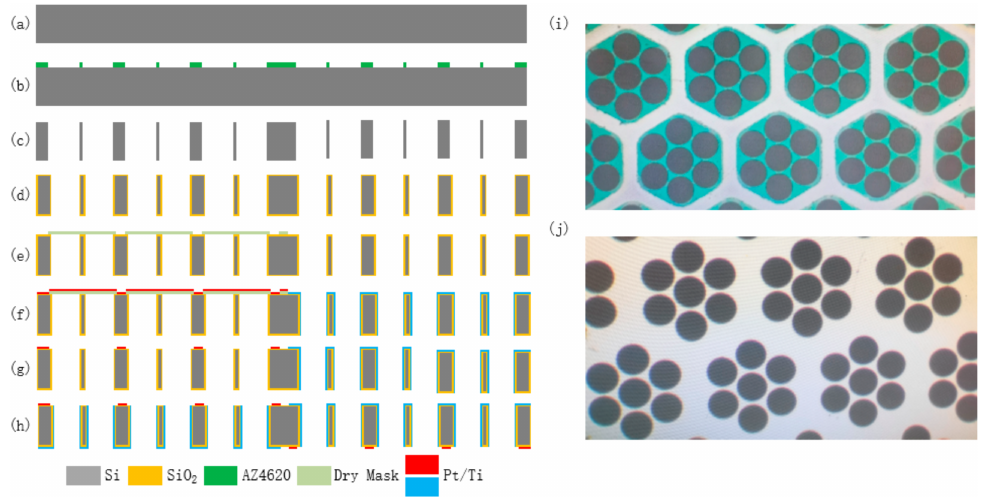
Figure 4. ( a – h ) Fabrication process of the integrative structure with four centrosymmetric micro electrodes. ( i , j ) Microscopic observation of flow holes on anode and cathode.